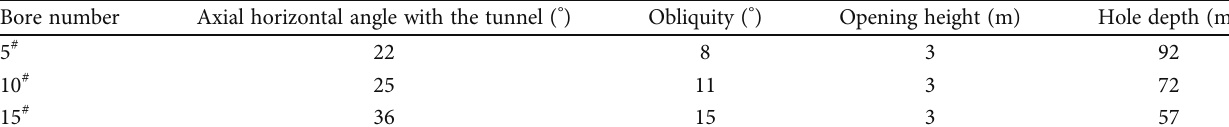
Table 1: Construction parameters of ordinary high-level drilling.